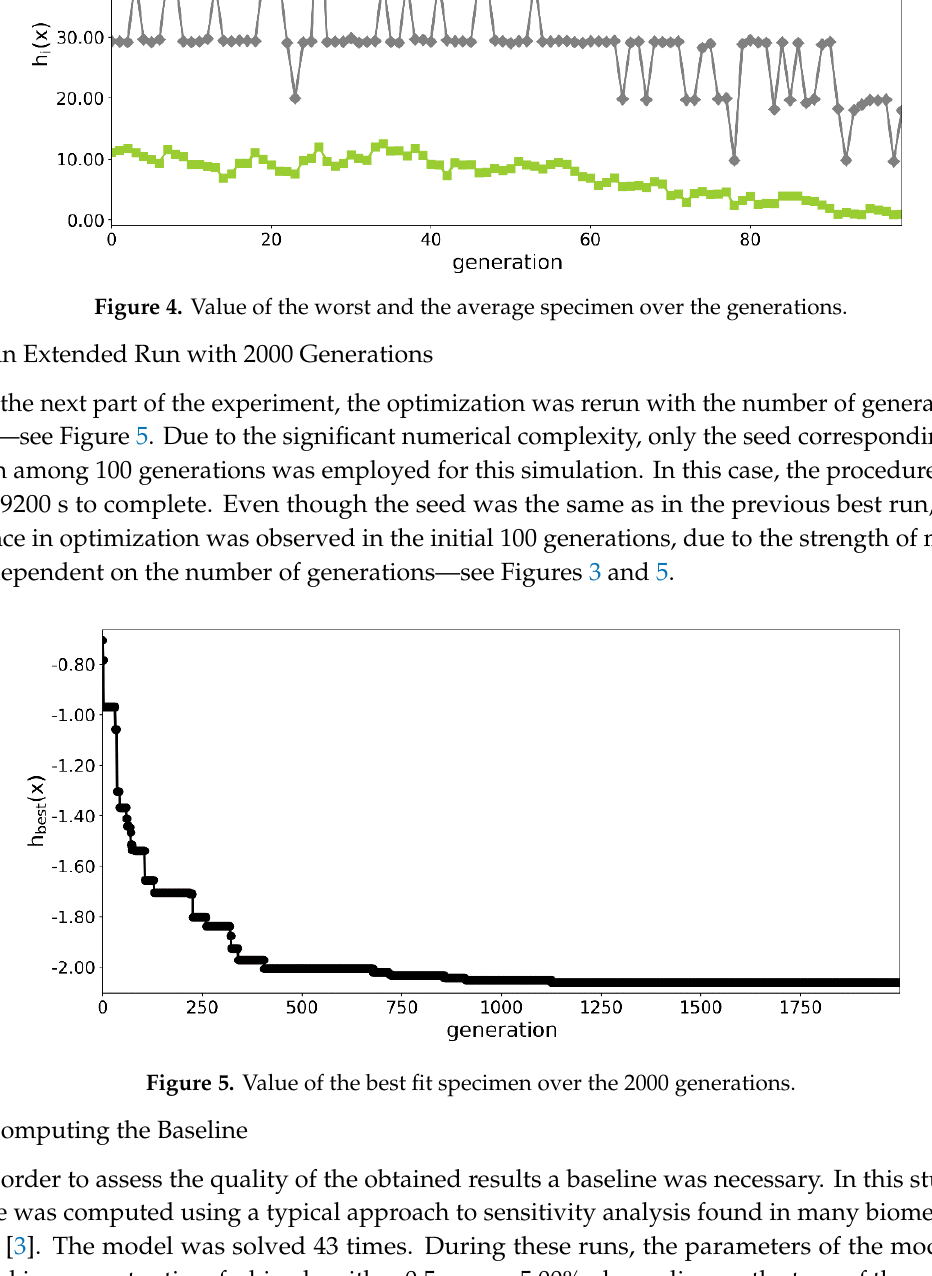
Table 1. Baseline obtained with one-at-a-time parameter modification compared to the results obtained with the proposed optimizational procedure Value of the objective h ( x )